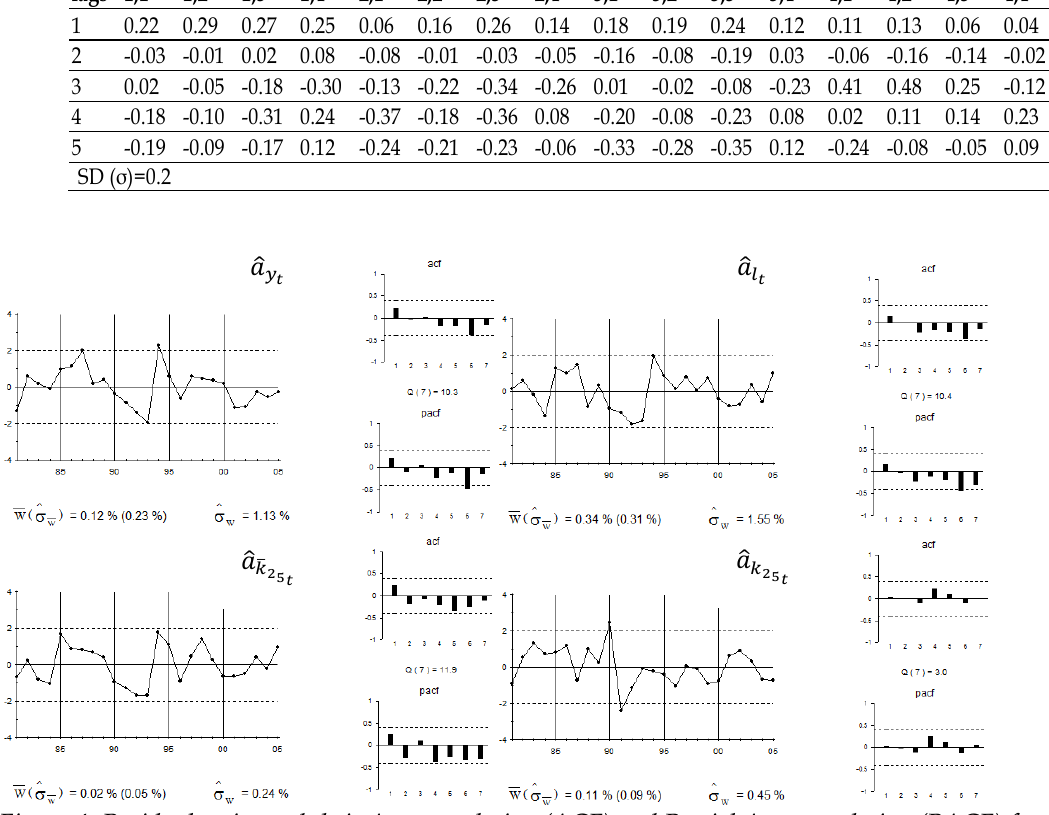
Figure 4. Residual series and their Autocorrelation (ACF) and Partial Autocorrelation (PACF)